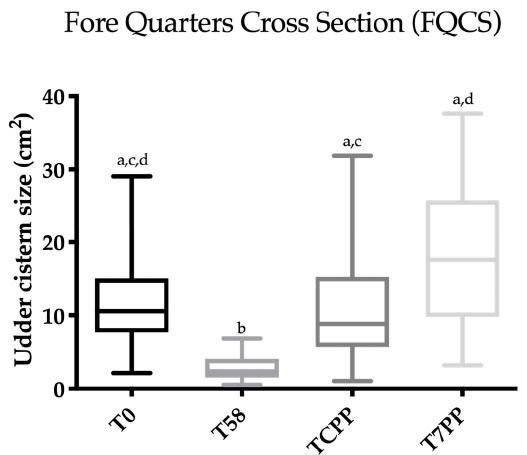
Figure 5. Scatter box plot showing the median, minimum and maximum values of the ultrasonographic udder cistern size between T0 vs. T58 vs. T colostrum production phase (TCPP) vs. T 7 days post-partum (T7PP) for the fore quarter cross section (FQCS). Legend: a ≠ b ≠ c ≠ d: p < 0.05.